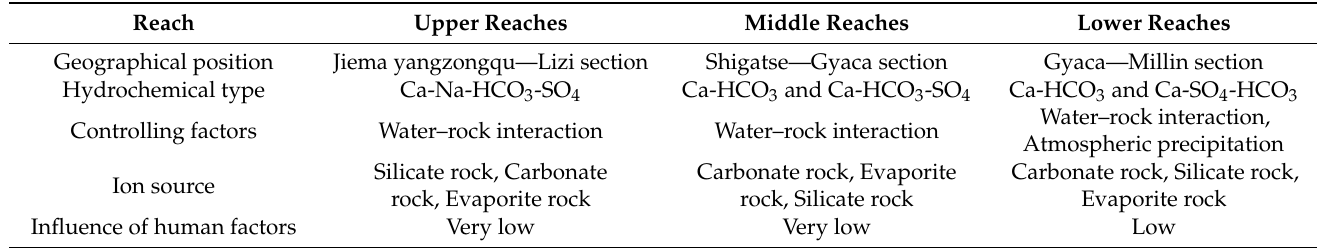
Table 4. Comparison of hydrochemical characteristics between the lower reaches and the middle and upper reaches of the Yarlung Zangbo